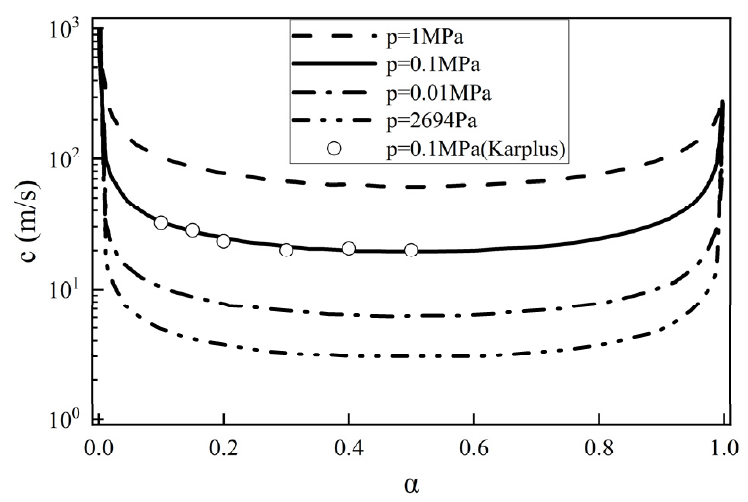
Figure 2. The sonic velocity of mixture under vapor volume fraction.